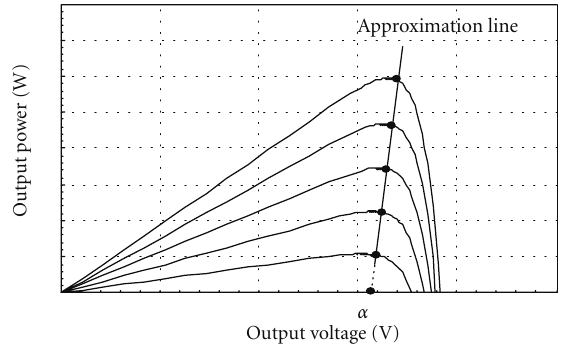
Figure 12: Illustration of the trajectory of maximum power point varying with insolation while PV temperature is invariant.